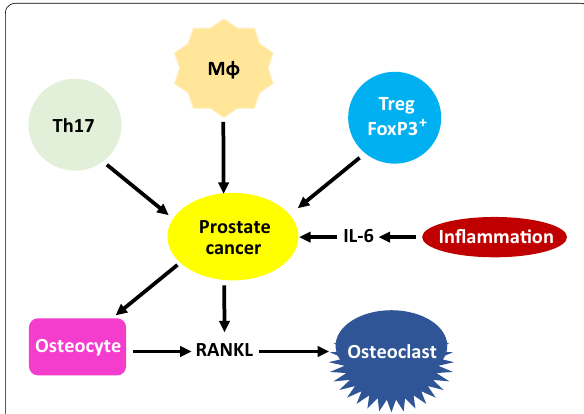
Fig. 1 Key immune cells and cytokines in the tumor microenviron- ment of prostate cancer. Tregs suppress the activation of anti-tumor T cells to promote tumor progression. Th17 cells may promote or inhibit prostate cancer progression depending on the context. Macrophages promote prostate cancer growth through efferocytosis. Inflammatory stimuli can lead to IL-6 production, which, in turn, can promote prostate cancer growth. Prostate cancer cells can produce RANKL directly and stimulate host cells (e.g., osteocytes) to produce RANKL in the tumor microenvironment. RANKL can then mediate tumor-induced bone remodeling through osteoclast activation. IL-6 interleukin-6, M ɸ macrophage, RANKL receptor activator of nuclear factor kappa-B ligand, Th17 T helper 17, Treg T-regulatory cell, FoxP3 forkhead box